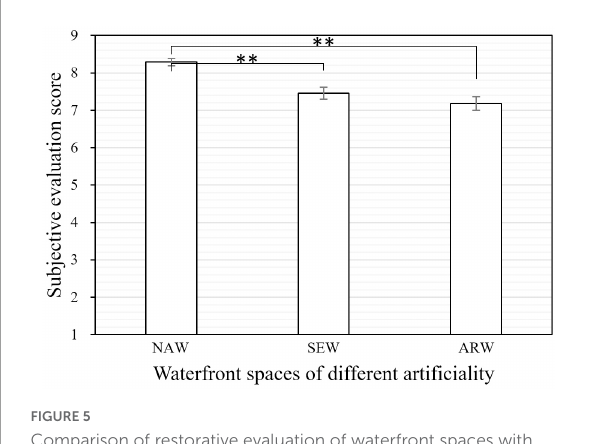
FIGURE5 Comparison of restorative evaluation of waterfront spaces with different degrees of artificiality. NAW, natural waterfront space; SEW, semi-artificial-semi-natural waterfront space; ARW, artificial waterfront space. (The error bars represent the standard errors on the averages: ± 1SE). Asterisks indicate statistically significant differences in mean scores (** p <